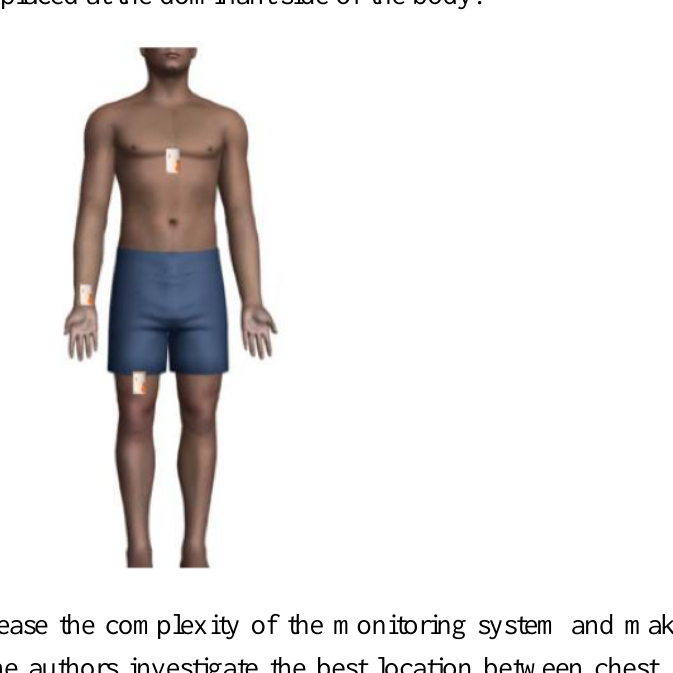
Figure 1. Selected placement locations for the accelerometers (chest, wrist and thigh). The wrist and thigh sensors are placed at the dominant side of the